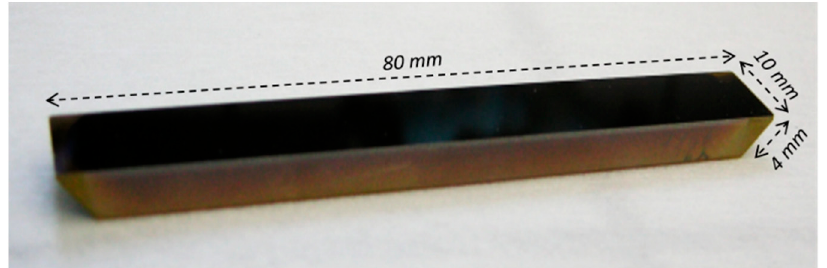
Figure 2. Ge 28 Sb 12 Se 60 chalcogenide thin film deposited by RF co-sputtering on an attenuated total reflection (ATR) ZnSe